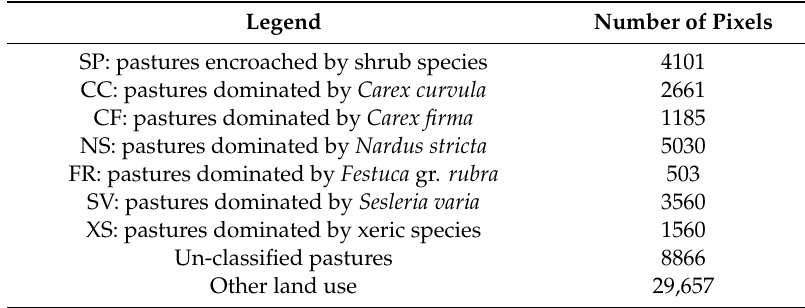
Table 1. Number of pixels (100 ha wide each) observed for each macro-types, unclassified pasturelands and other land uses of the training dataset (response